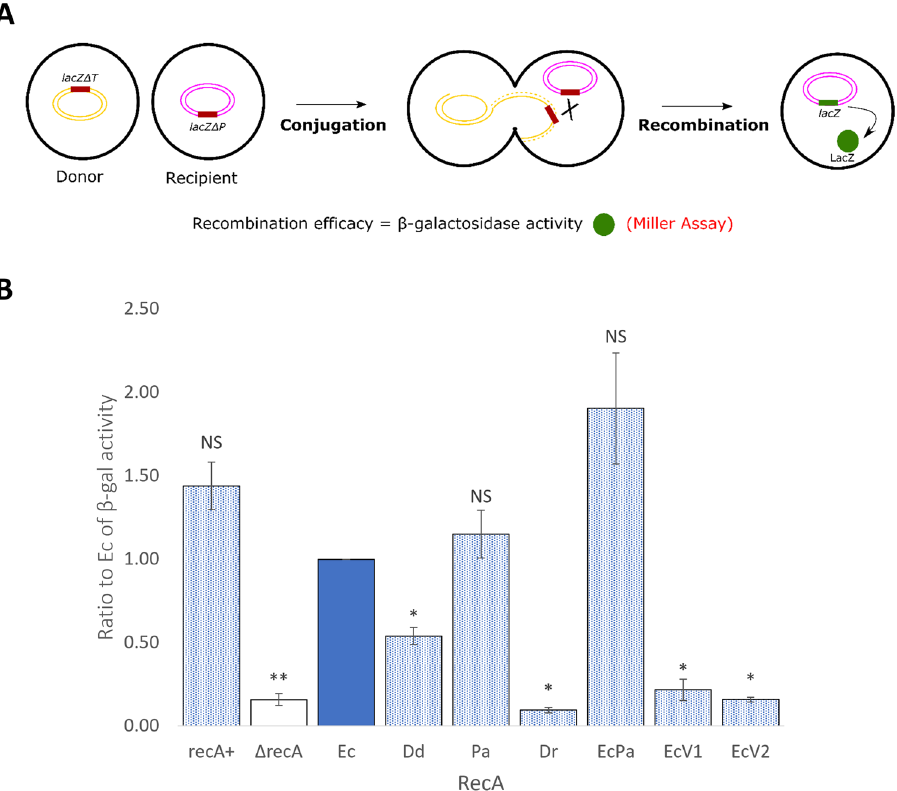
Figure 7. Recombinogenic activity of RecA variants. (A) The scheme represents the recombination and reconstitution of lacZ gene after conjugation and consequent recombination between the fragments lacZΔT of the donor and lacZΔP of the recipient. ( B) Recombination was assessed by measuring the β-galactosidase activity resulting from the restoration of an intact lacZ gene after conjugation of MG1655 nalR lacZΔP recA ::Cm cells harbouring pQE-80L plasmid derivatives containing each of the seven recA variants with Hfr3000 lacZΔT CmR under protein induction with 0.05 mM IPTG. The β-galactosidase activity was assessed by Miller’s assay. The ratios of β-galactosidase activity in the presence of the variant versus β-galactosidase activity in the presence of EcRecA, used as a reference, were calculated for 3 different biological experiments. These ratios are plotted as a histogram. The strains analysed are RecA + strain (blue dot filled bar), ΔrecA strain (unfilled bar), the ∆recA strain producing EcRecA (blue filled bar, it is the reference but is presented for visual comprehension) and ∆recA strains producing PaRecA, DrRecA, EcPa, EcRecAV1 and EcRecAV2 variants (blue dot filled bars). NS indicates a non-significant p-value (from the one sample t test compared to 1, the EcRecA value), * indicates a significant p-value < 0.05 and ** a significant p-value < 0.005. Error-bars indicates